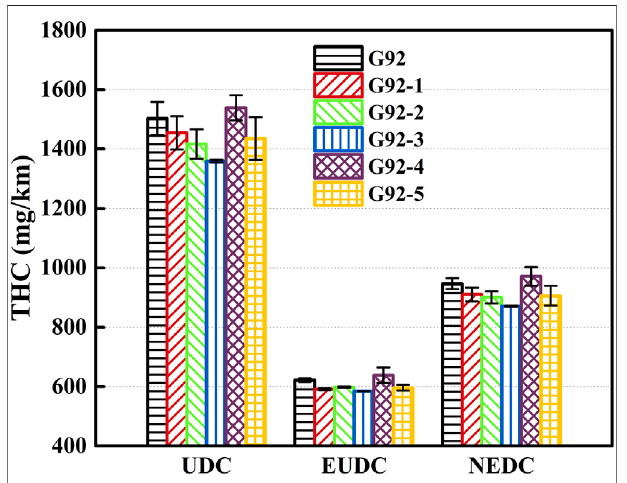
FIGURE 7 | The CO 2 emission of the vehicle fueled with different test